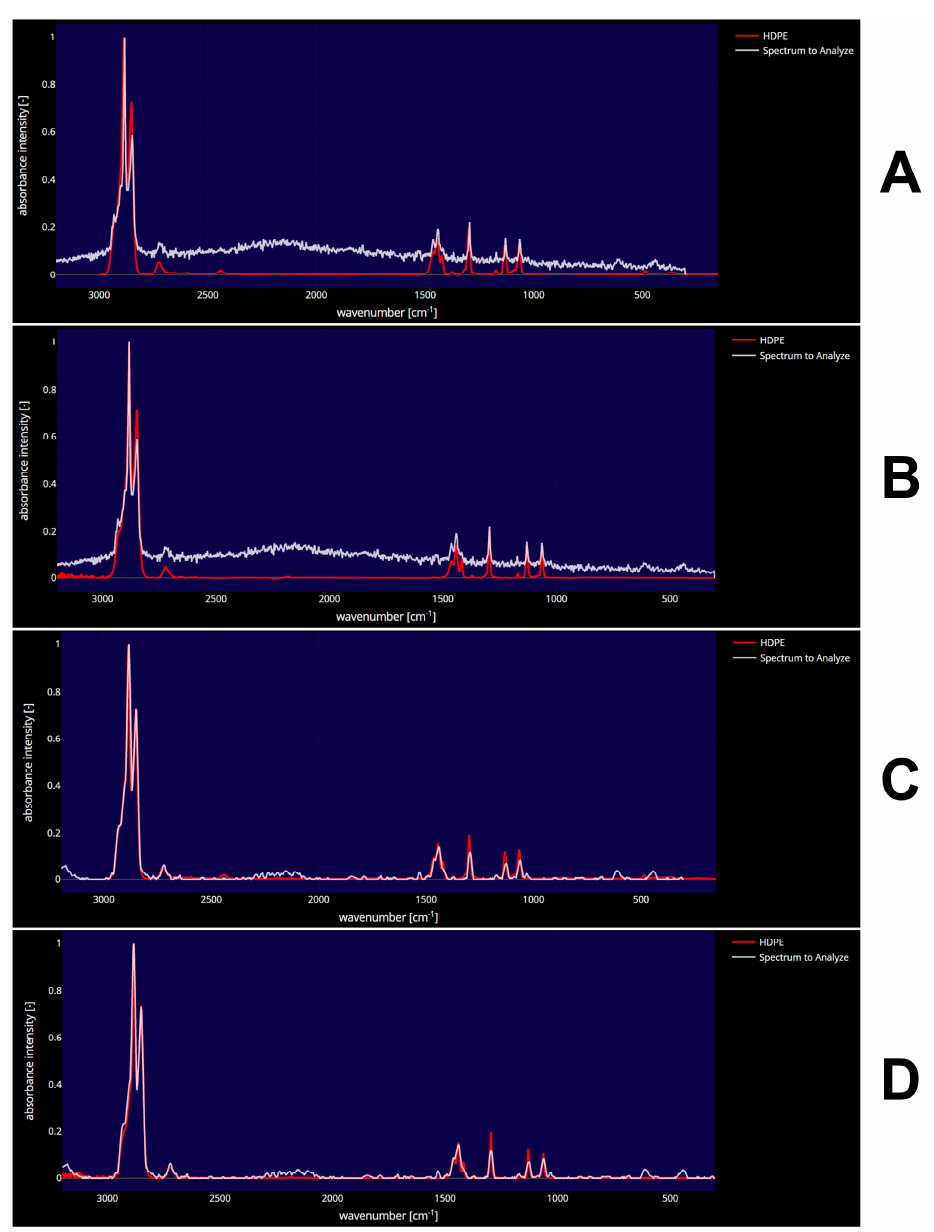
Figure 2. High-Density Polyethylene (HDPE) micro-Raman spectrum comparisons: ( A ) upstream in Klaipeda; ( B ) wastewater influent in Klaipeda; ( C ) wastewater effluent in Klaipeda; and ( D ) down- stream in Klaipeda.